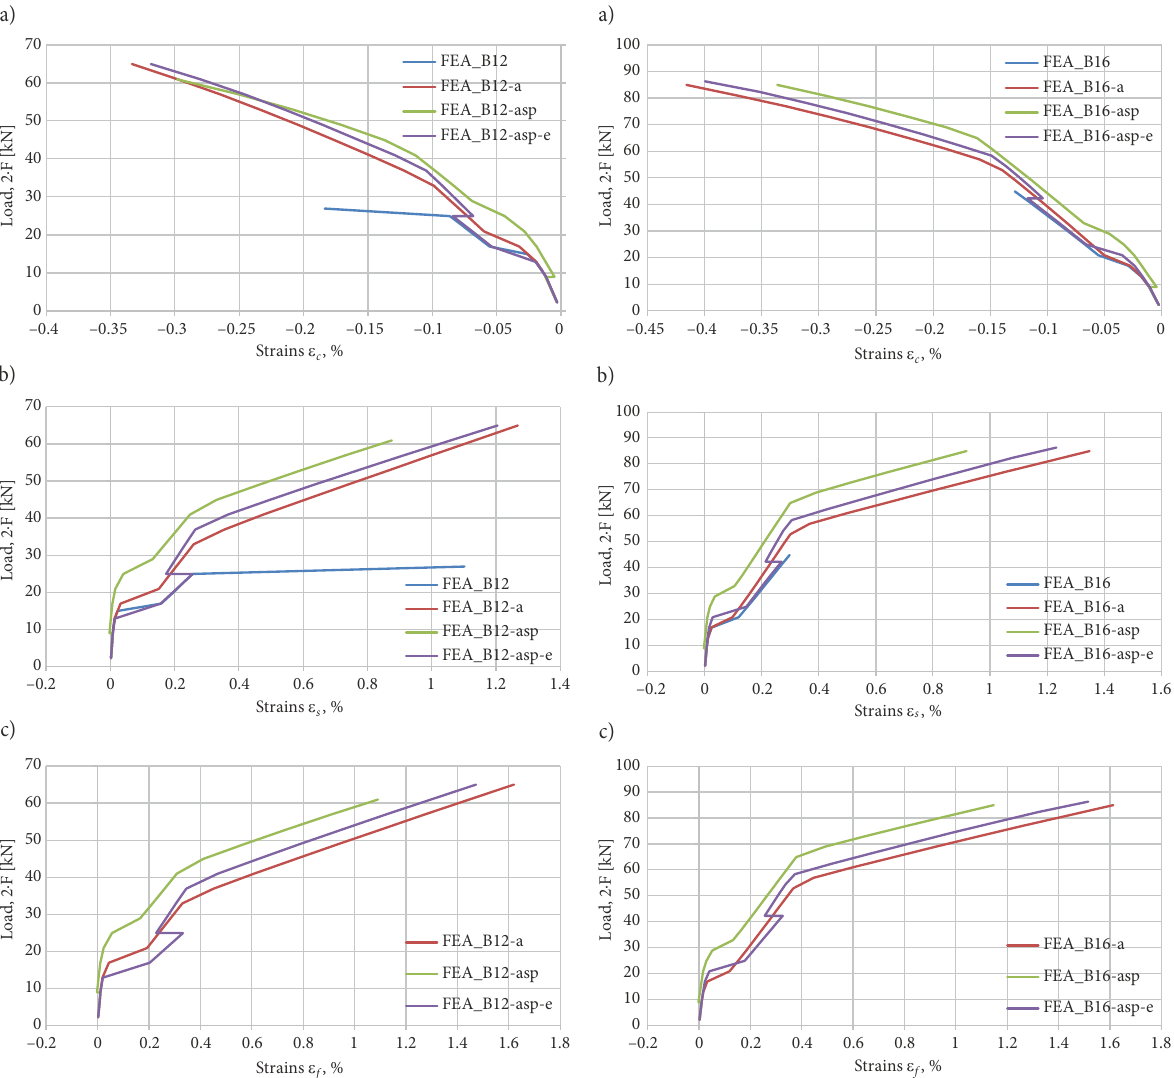
Fig. 9. External load vs strain, curves predicted numerically reinforcement, 4 ∅ 16: a – ε